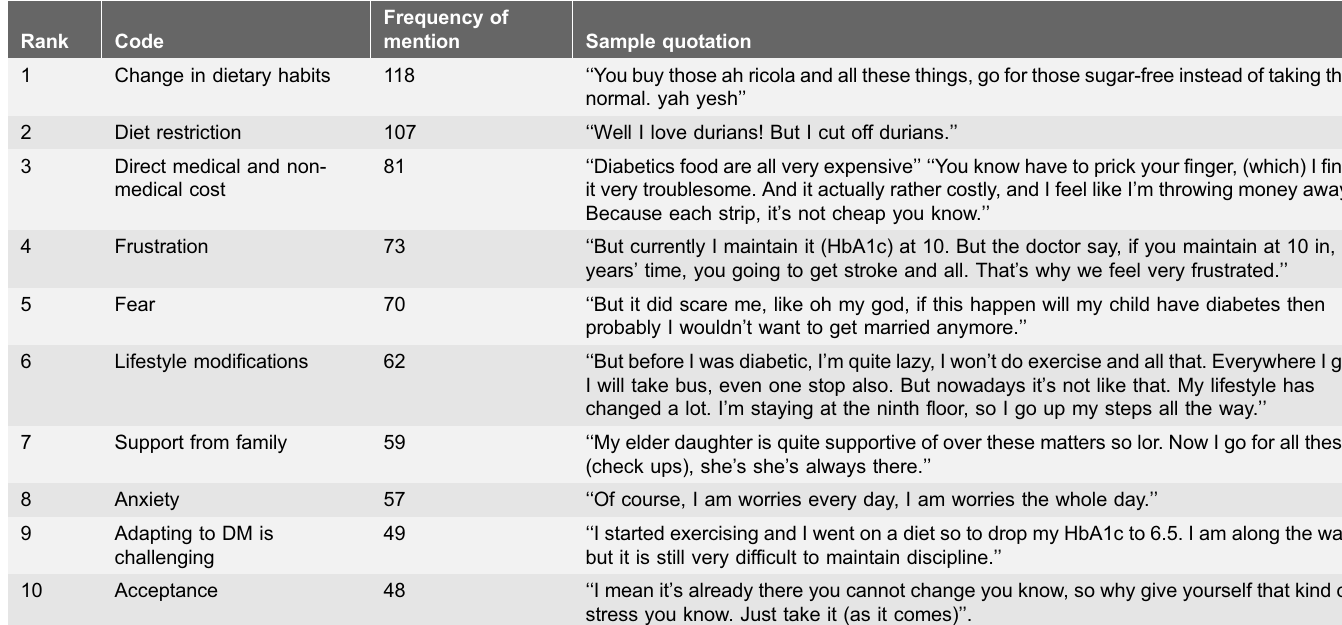
Table 1. Top 10 most frequently mentioned